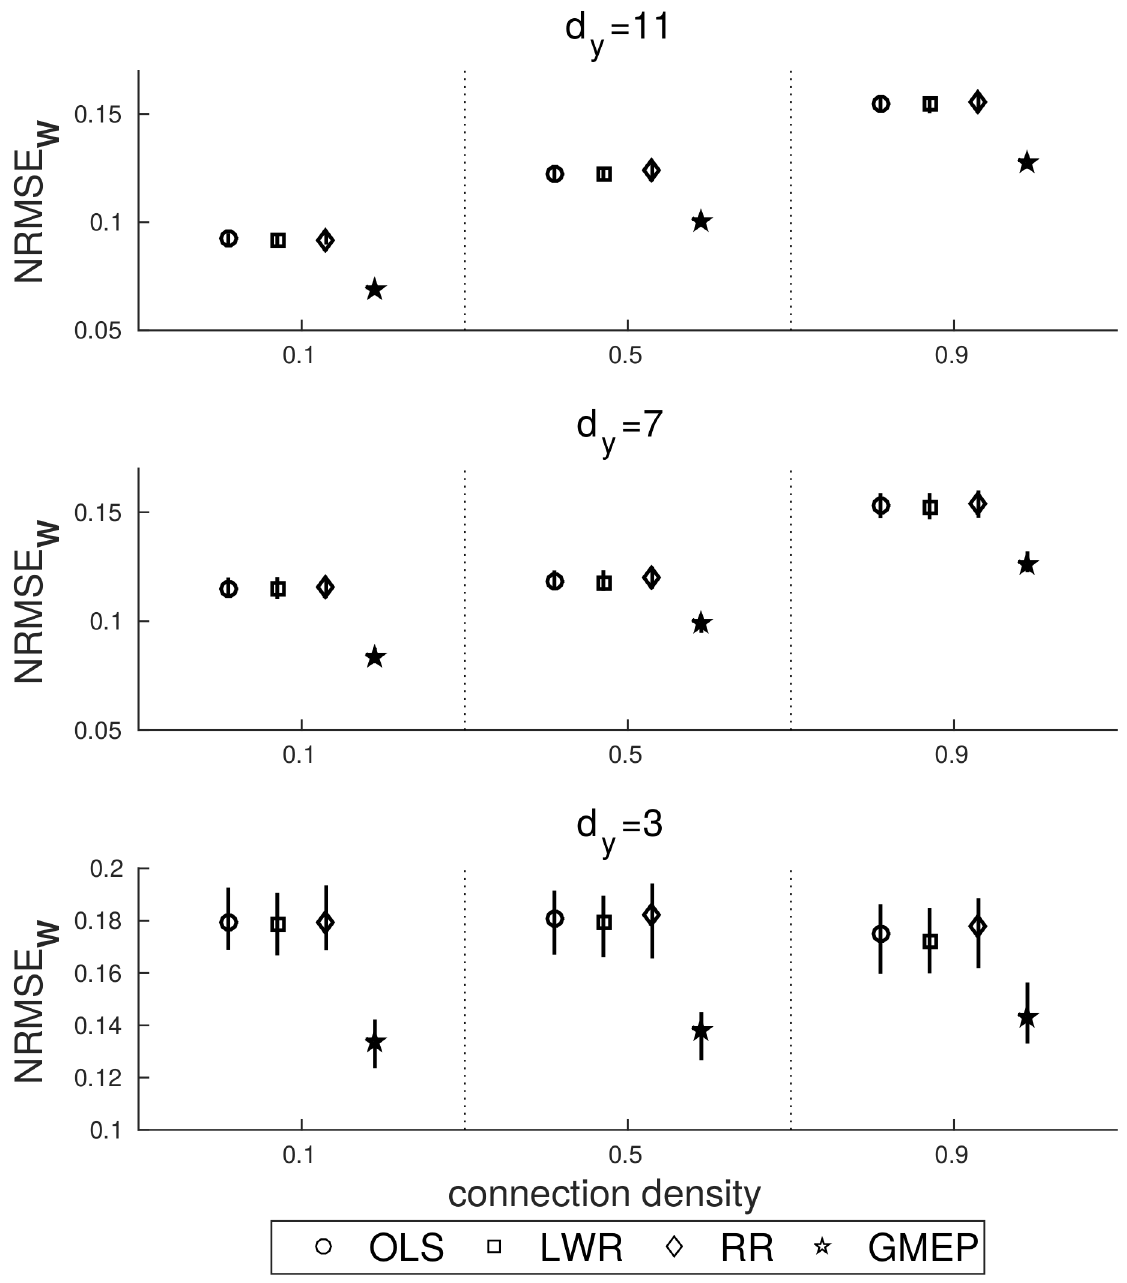
Fig 2. NRMSE related to the coefficient estimations, each inference method is identified by a specific markerand its result is reported in terms of median, 25-th and 75-th